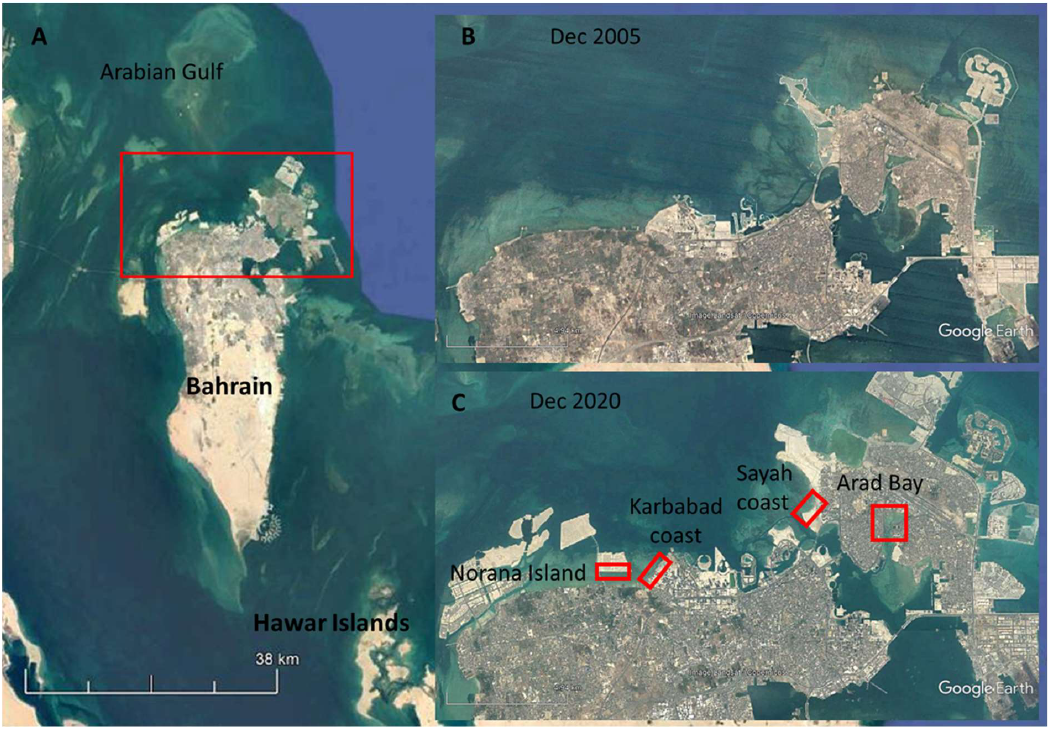
Figure 1. A map of Bahrain ( A ), the northern coastline of Bahrain in December 2005 ( B ) and the northern coastline of Bahrain in December 2020, showing the approximate locations of the sampling sites ( C ) (Google Earth Pro).